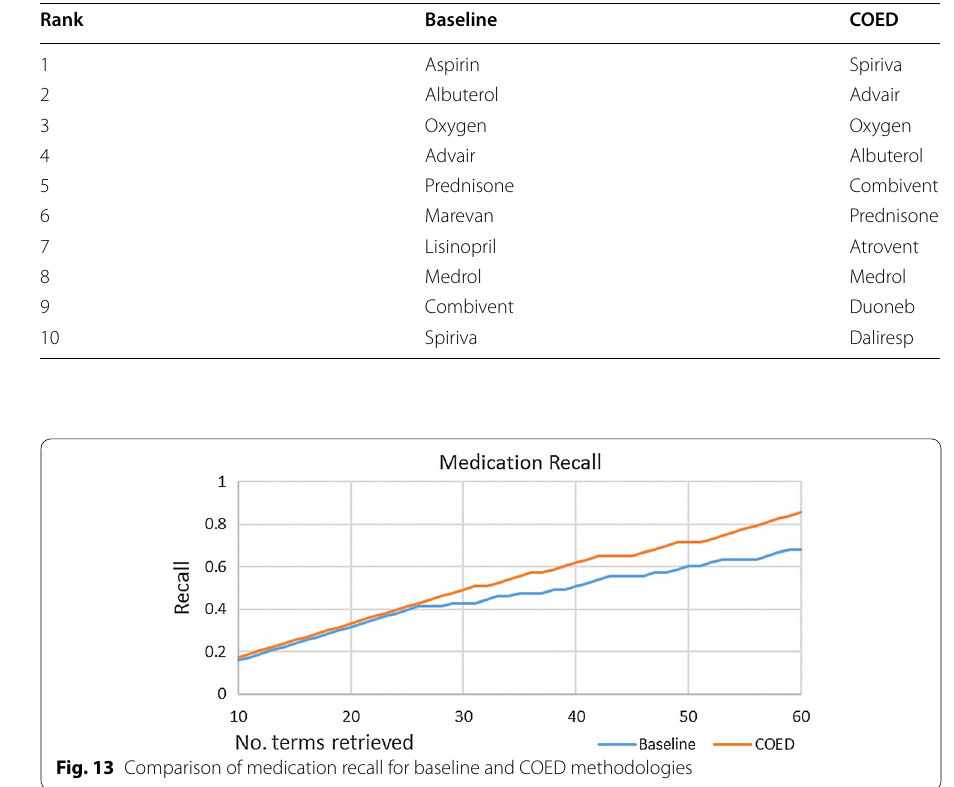
Table 5 Selection of top ten results for medications